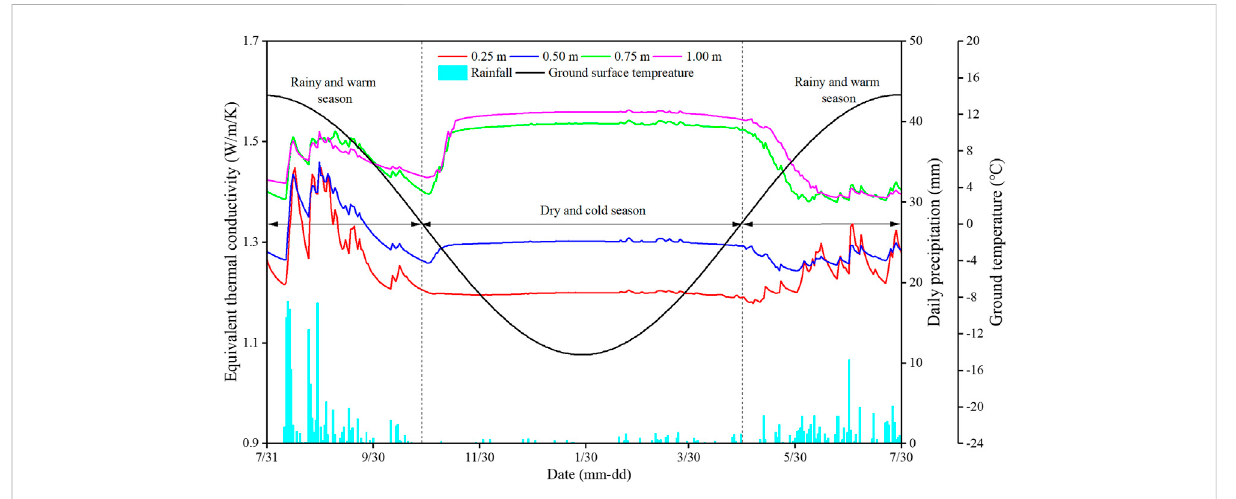
FIGURE 11 The ETC of sand layer with different thickness in the 20th